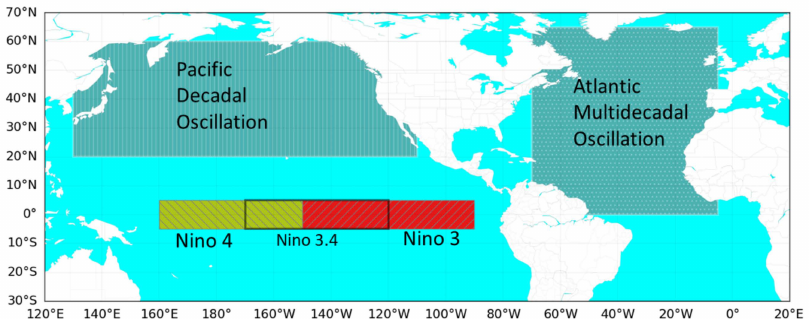
Figure 3. Location of the di ff erent modes of ocean–atmosphere